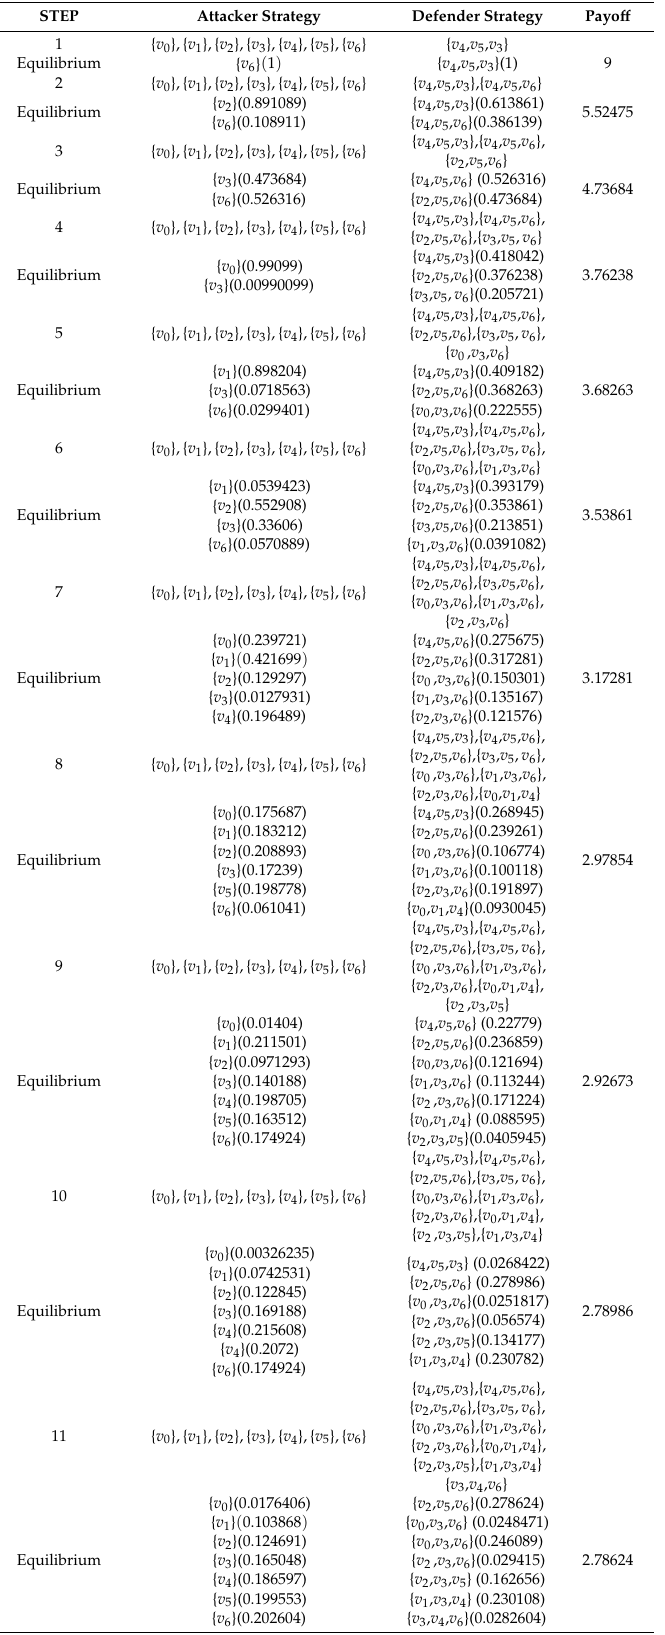
Table 3. The Process of